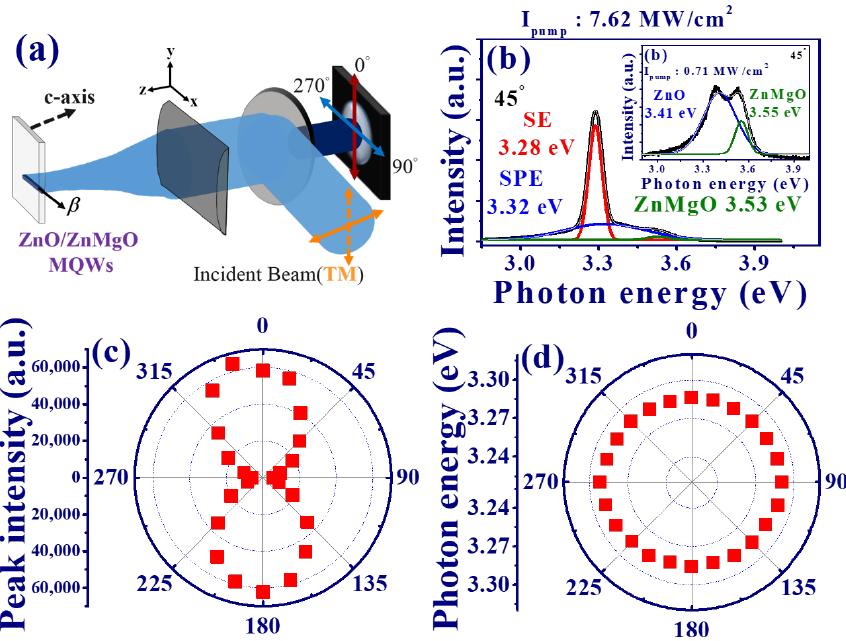
Figure 4. ( a ) Schematic illustration of the normal emission from MQWs through the pump of a Q-switched laser. ( b ) ASE spectrum from the surface normal of MQWs at θ = 45 ◦ . (Inset: SPE spectrum), ( c ) peak intensity and, ( d ) photon energy of ASE from the surface normal of MQWs (TM mode pump polarization). Table 1. Investigation of ASE from ZnO and ZnO/ZnMgO